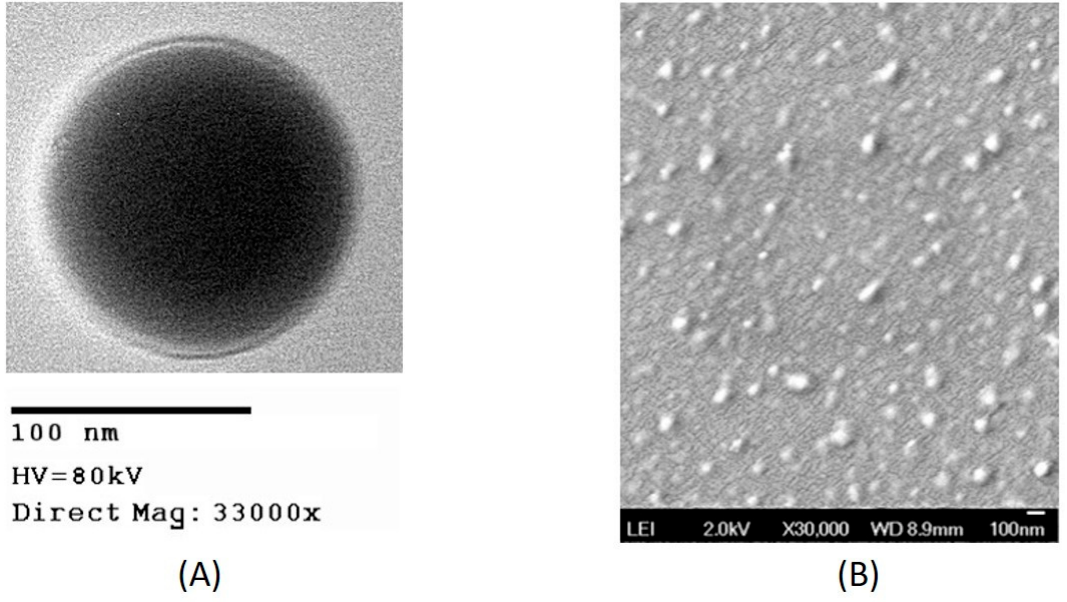
Figure 2. Images of GSK encapsulated in PLGA-PEG nanoparticles from ( A ) transmission electron microscope ( B ) scanning electron